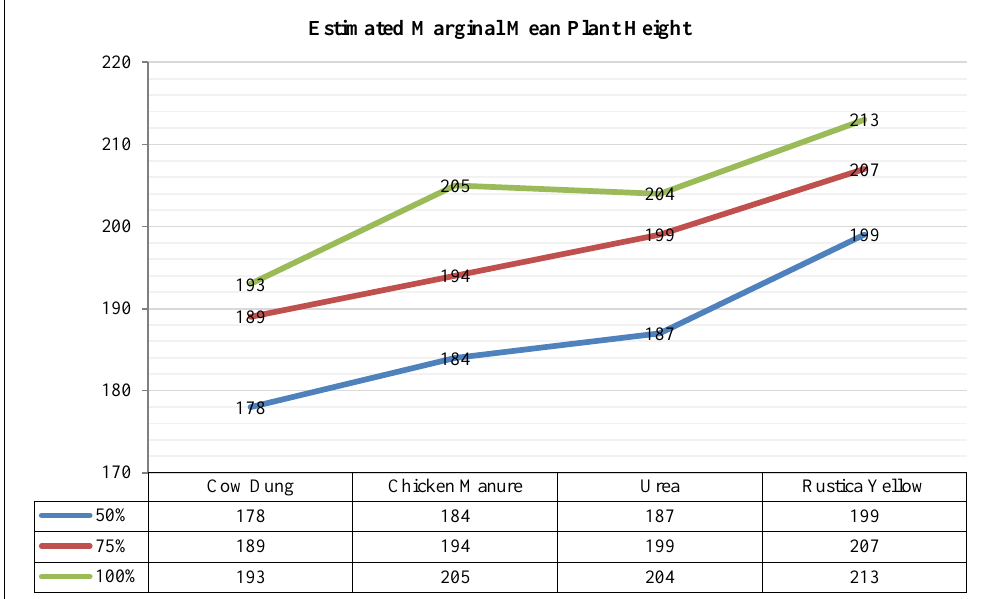
Figure 2. Effect of Nitrogen Sources and Levels on the Height of the King